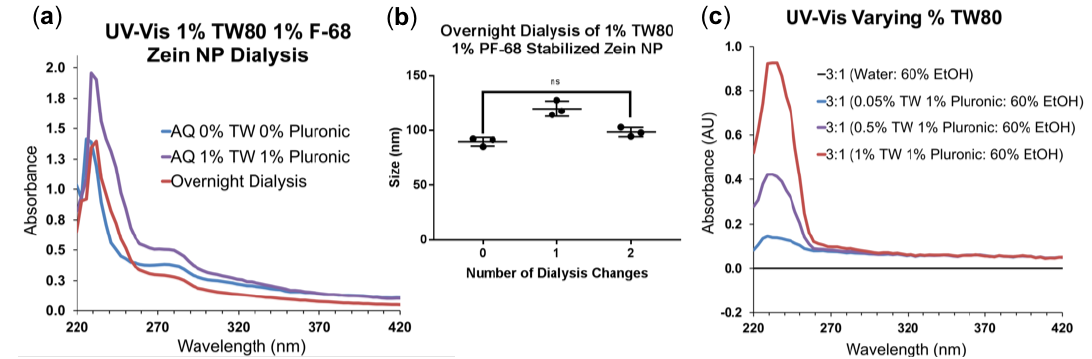
Figure A2. Removing excess stabilizers not incorporated in Zein nanoparticles (NPs): ( a ) Ultraviolet- Visible Spectroscopy (UV-Vis) of the 1% Tween 80 (TW80) 1% Pluronic F-68 (PF-68) NP before and after dialysis with control sample containing no stabilizers for reference; ( b ) the change in size of the 1% TW80 1% PF-68 at each dialysis change; and ( c ) UV-Vis of the TW80 present in each of the Zein NP samples with stabilizers.